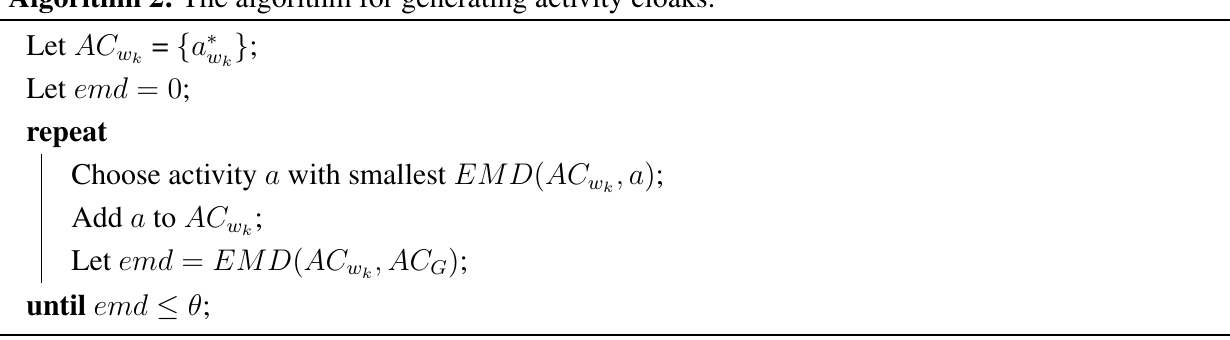
Algorithm 2: The algorithm for generating activity